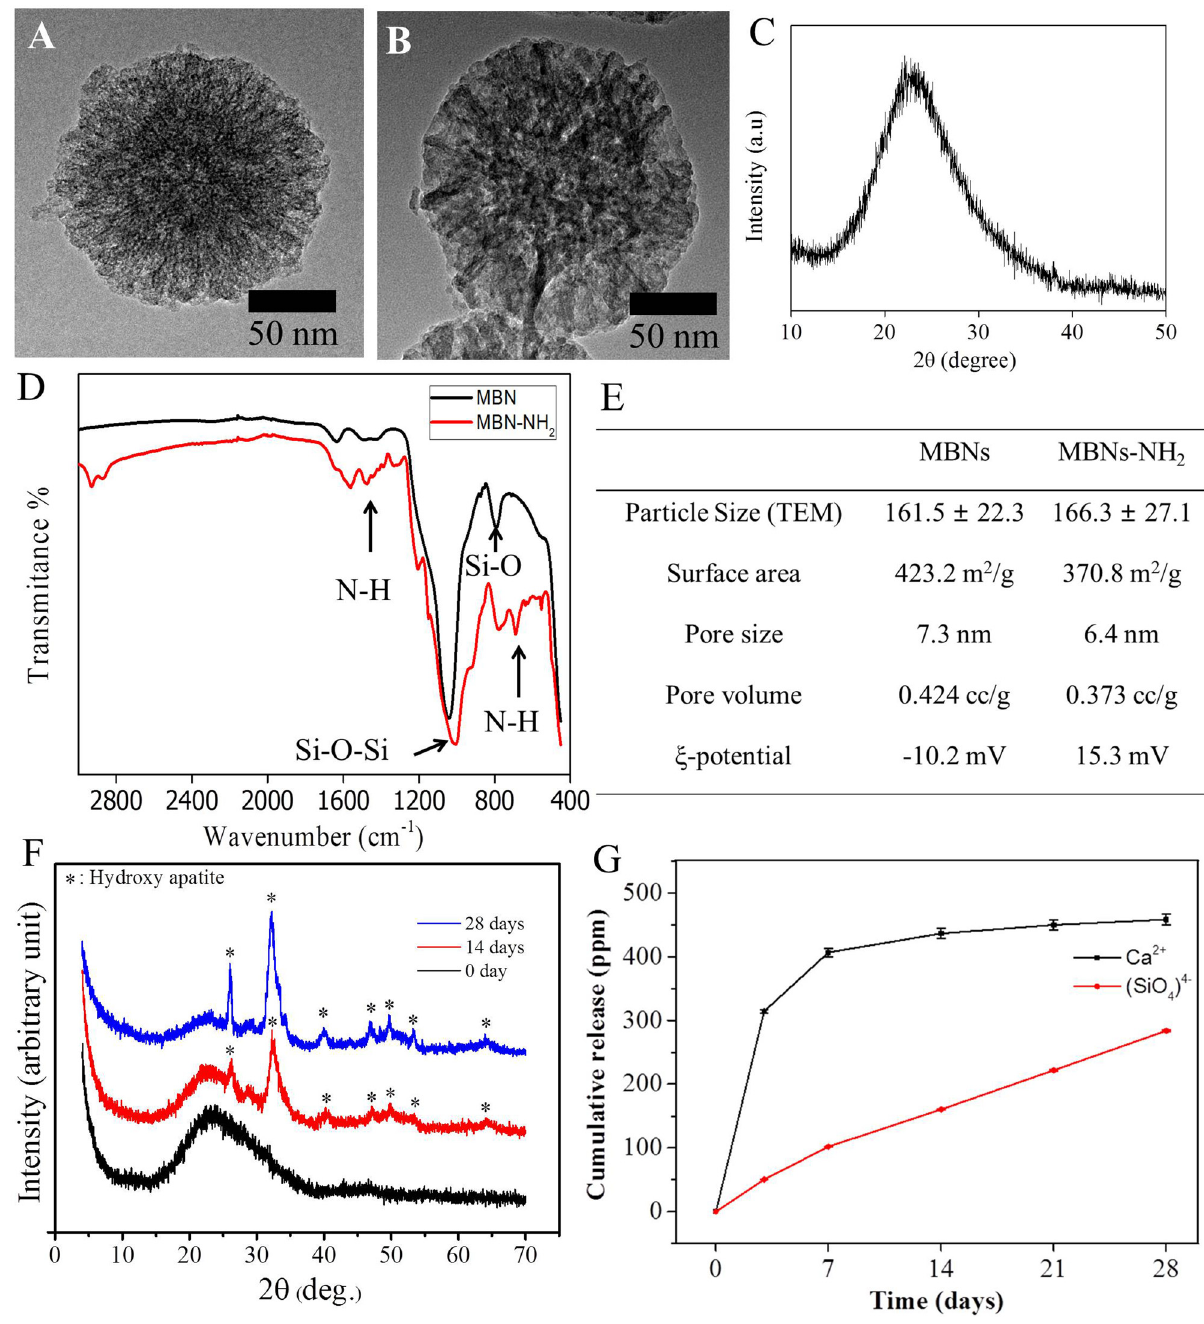
Fig 1. Characteristics of MBNs before and after amination . Transmission electron microscopic images showing MBNs (a) and MBNs-NH 2 (b) with a highly mesoporous structure. ( c ) X-ray diffraction (XRD) pattern of MBNs-NH 2 showing an amorphous glass phase. ( d ) Amine functionalization was confirmed on Fourier transform infrared spectroscopy (FTIR). ( e ) A shift of zeta ( ξ )-potential to positive charge was observed after amine functionalization and summary of mesoporous characteristics of MBNs and MBNs-NH 2 . ( f ) XRD pattern of MBNs-NH 2 after immersion in simulated body fluid for 14 or 28 days showing hydroxyapatite precipitation. ( g ) Cumulative release of ions from MBNs-NH 2 detected by inductively coupled plasma atomic emission spectrometry (ICP-AES) analysis. The measurements were performed in triplicate, and representative results are shown.